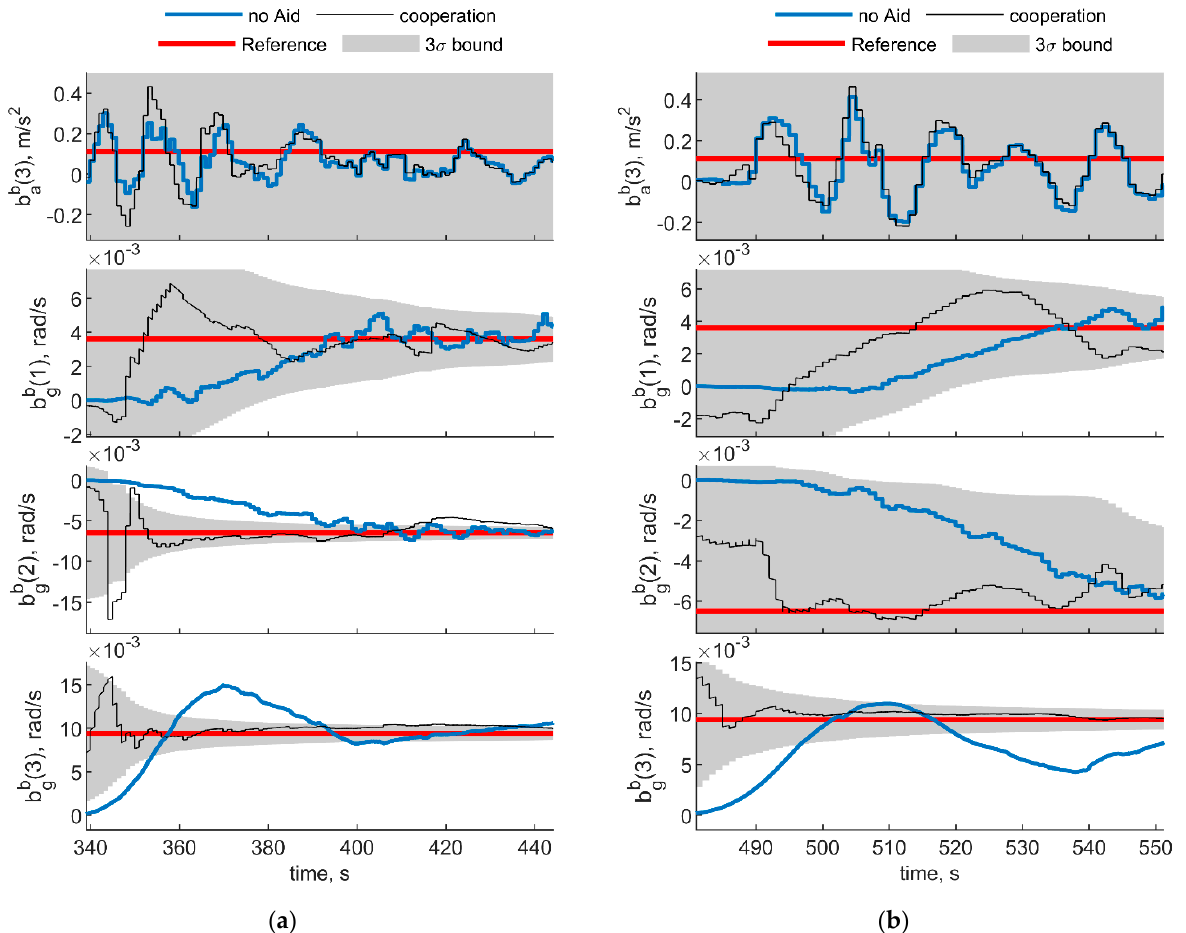
Figure 24. Down accelerometer and gyroscopes biases experimental results. ( a ) Two deputies. Chief and deputy trajectories are reported in Figure 22. ( b ) One deputy. Chief and deputy trajectories are reported in Figure 23. Reference value obtained from the ZUPT filter is reported in red, whereas results obtained with cooperation and without cooperation have been reported in black and blue, respectively. 3 σ bound is reported in gray.